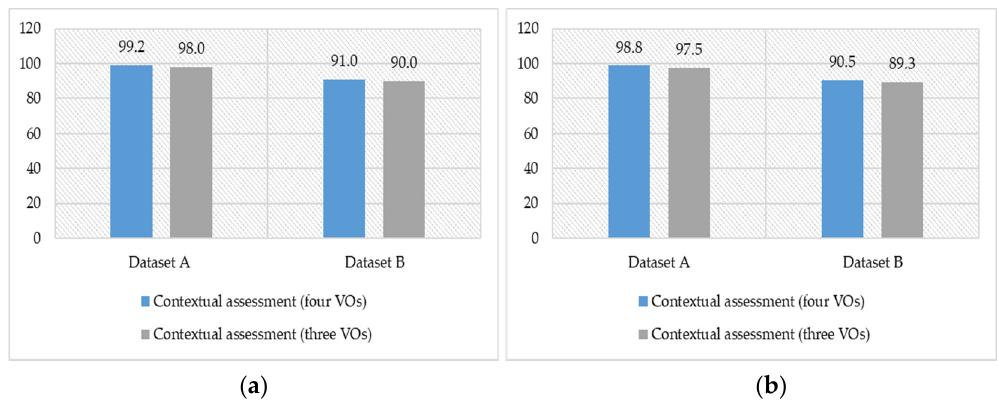
Figure 28. Appropriate amount of data for the ASC ( a ) and TMC ( b ) applications CVOs.